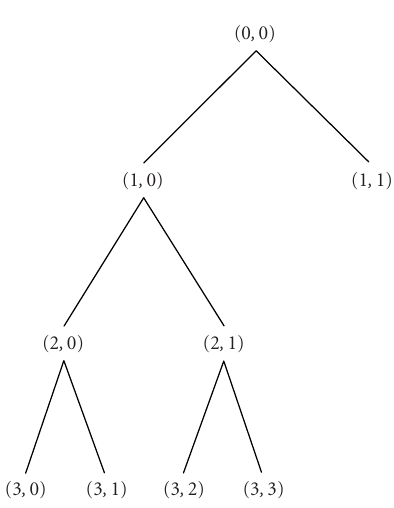
Figure 3.14. Wavelet packet with optimal subtree.